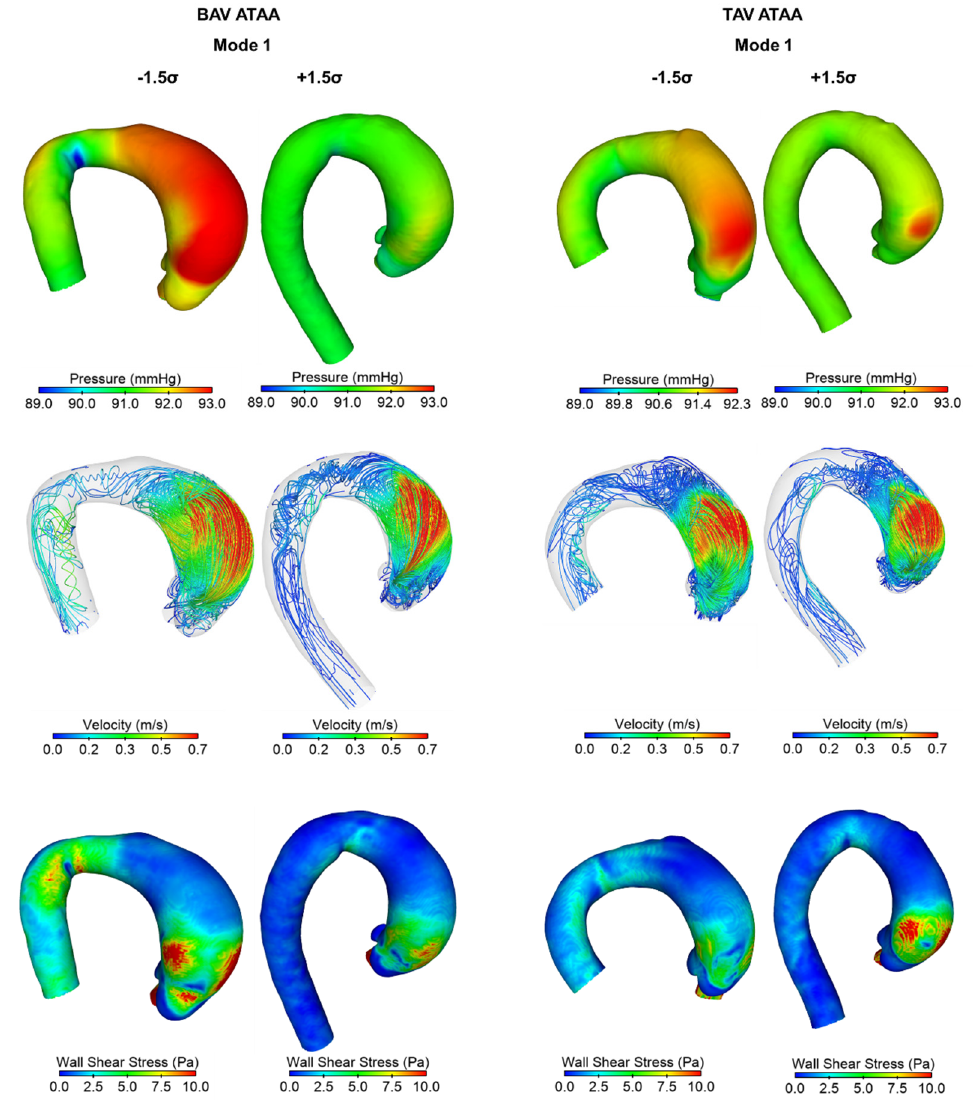
Figure 6. Pressure ( top ), flow velocity ( center ), and WSS ( bottom ) for BAV and TAV ATAA models for Mode 1 at ±1.5 σ .